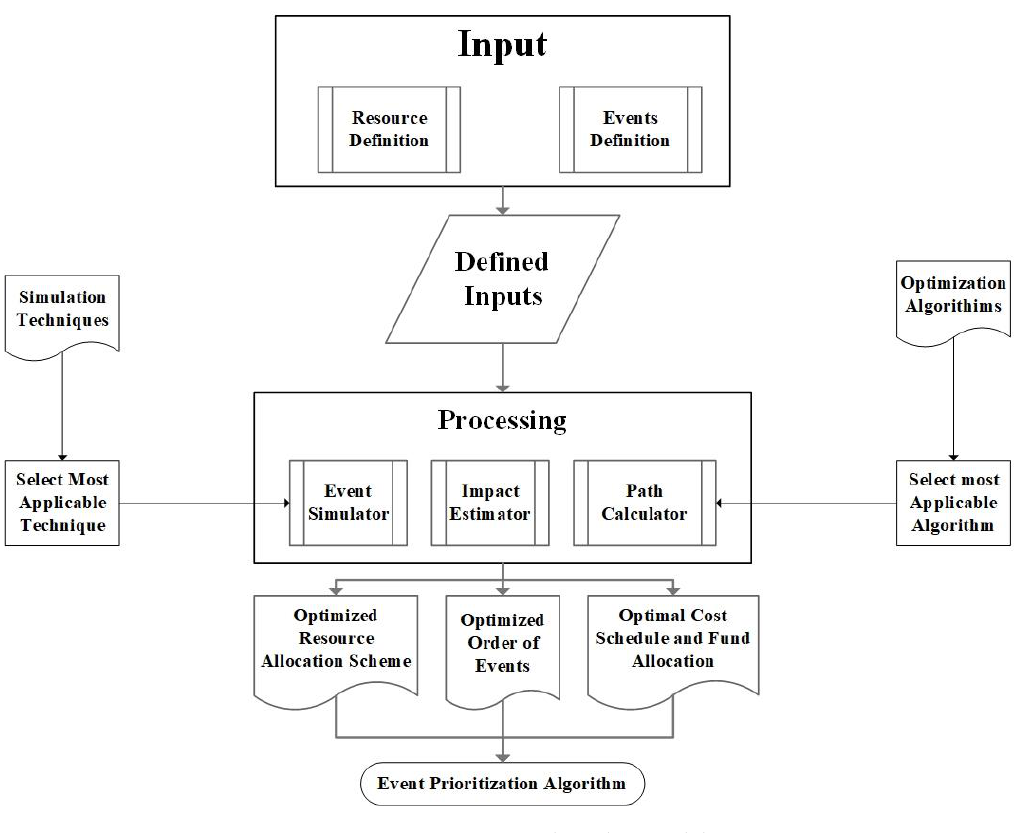
Figure 1. Lazy Serpent Algorithm model.